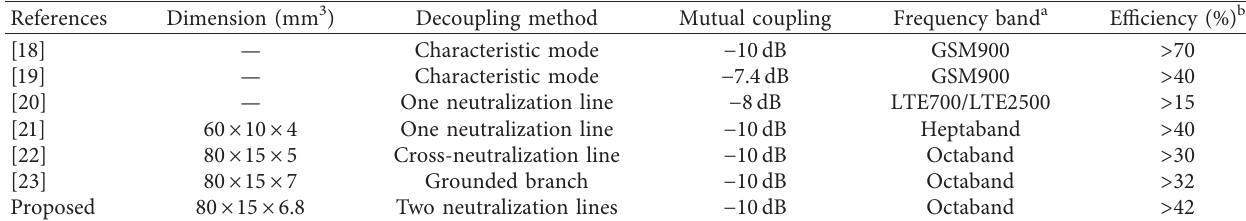
Table 1: Figures of merit of octaband WWAN/LTE dual-antenna